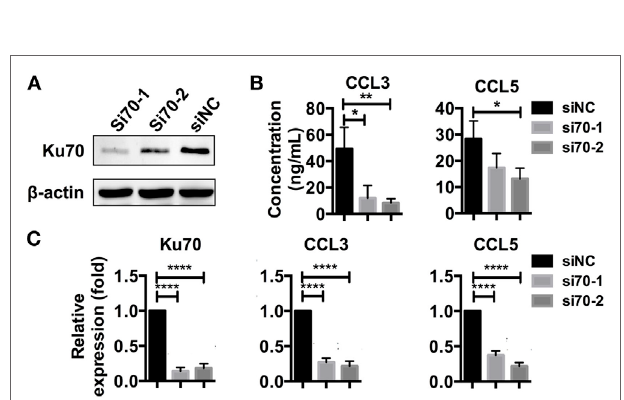
FigUre 5 | Knockdown of Ku70 expression impacts chemokine upregulation . (a) SK-Hep-1 cells were treated with Ku70 RNAi. Six hours later, the cells were harvested, and Western blotting was performed to measure Ku70 expression. (B,c) SK-Hep-1 cells were treated with RNAi against Ku70 24 h before pAAV-HBV1.2 plasmid transfection. Forty-eight hours later, the secreted CCL3 and CCL5 protein levels in the cell culture supernatant were determined by ELISA (B) , and RT-PCR and real-time qPCR were performed to determine the mRNA expression (c) ( n = 3).